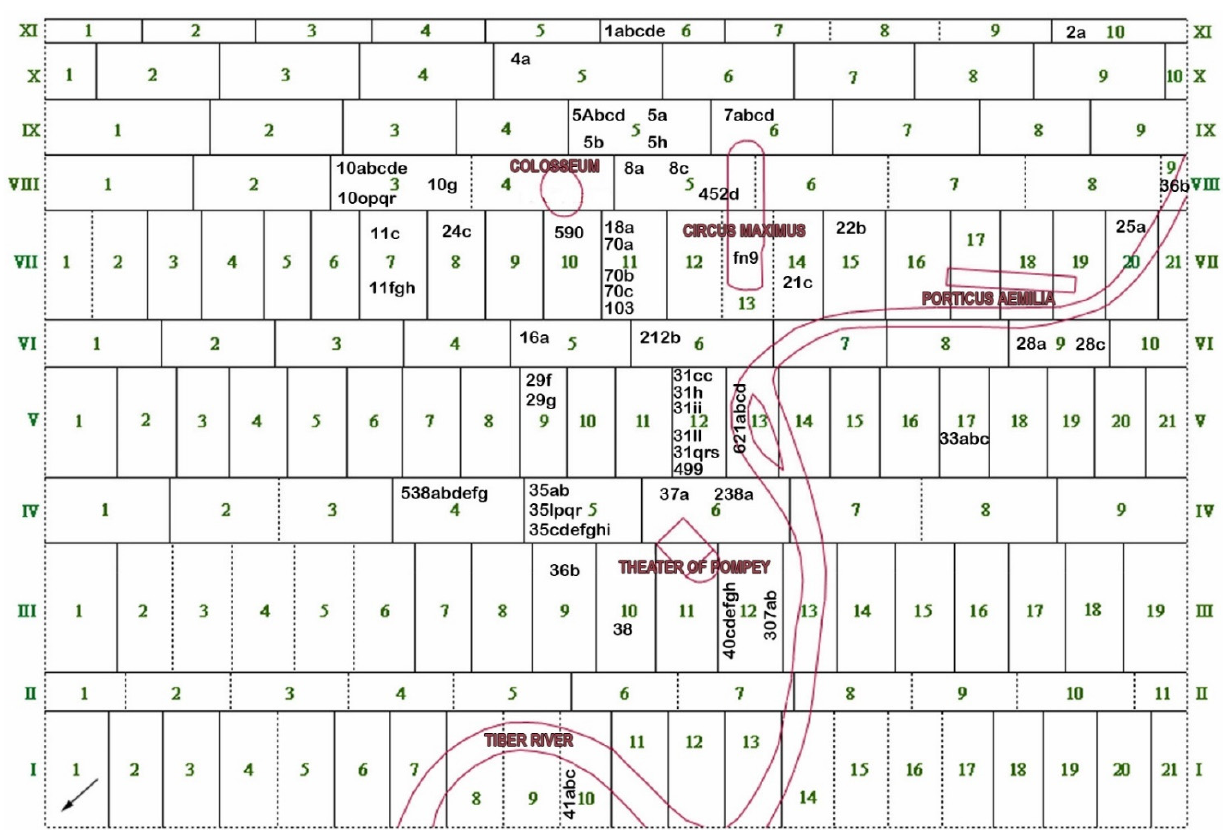
Figure 2. Slab map of the F.U. showing the slab numbering code (in green) adapted from the Stanford Digital Forma Urbis Romae Project in which the Tiber river course and some important structures have been highlighted (in purple). The presumed position of the 53 sampled labelled fragments has been indicated, and 40 unlabeled fragments were also sam ‐ pled.